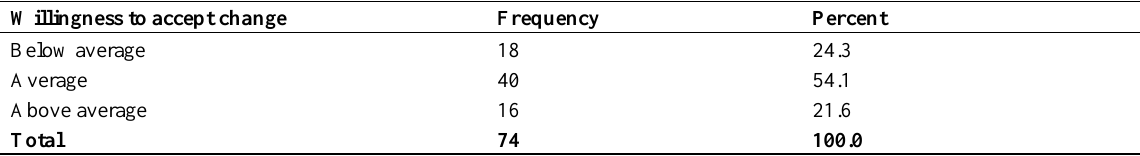
Table 7: Parents rating of their School Manager’s